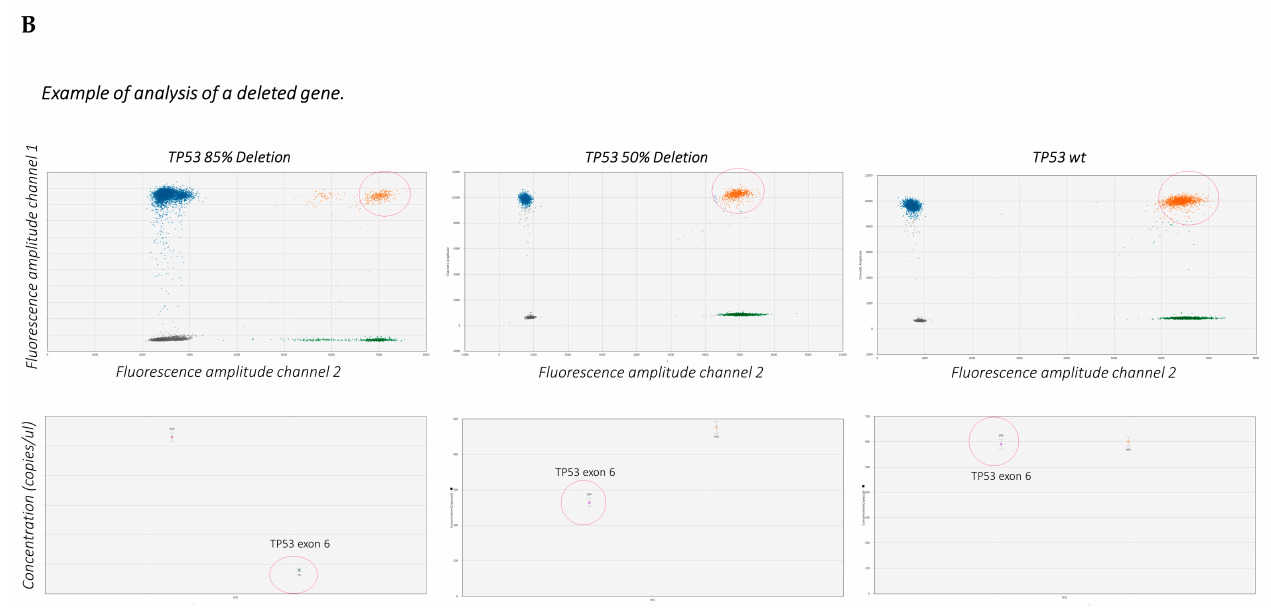
Figure 3. ( A ) Overview of the ddPCR procedure. ( B ) The graphs show examples of the analysis of TP53 CNV obtained from a previous work carried out by Frazzi and coauthors [43]. These graphs show the wild-type (wt) TP53 gene (right panel), TP53 with 50% deletion (middle panel) and 85% deletion (left panel). The increase in gene deletion corresponds to a decrease of the positive population (orange dots, red circled). The orange population is the double-positive